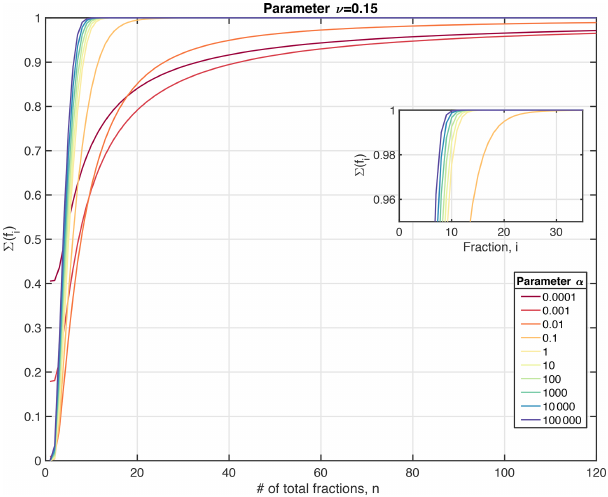
Figure 2. Quality of the multi-G approximation (expressed as the sum of the reactive fractions) as a function of the number of re- activity bins, n , for different RCM parameter a (here shown for ν = 0 . 15). The sum of (cid:80) i (f i ) should approach 1.0 for an adequate approximation. More reactive OM mixtures (i.e. represented by a small parameter a ) require a larger number of fractions n than more unreactive OM mixtures (i.e. a larger parameter a ) to achieve a good approximation of the gamma